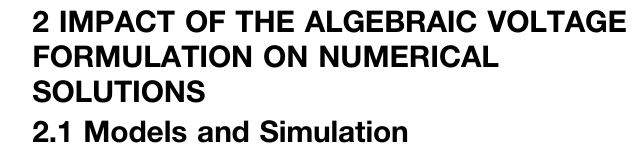
Frontiers in Physiology |